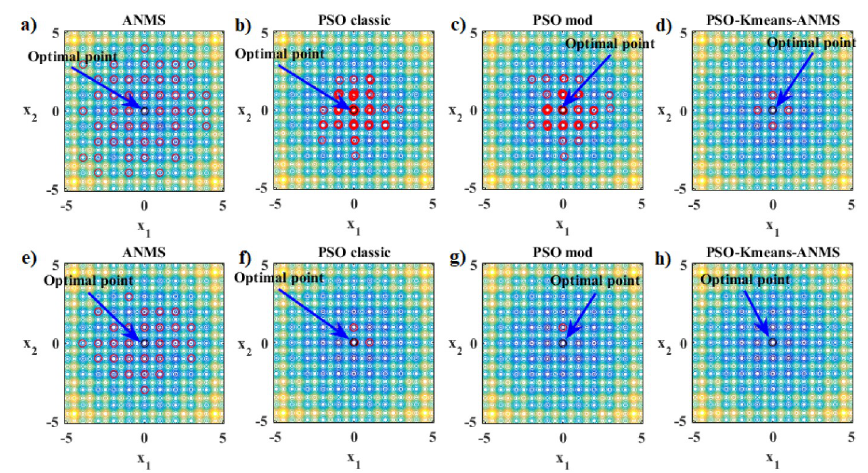
Fig 14. Simulations details for the Rastrigin function. The 100 results obtained by the algorithms ANMS, PSO classic, PSO mod and PSO-Kmeans-ANMS for the swarms with 08 (upper) and 36 (lower) particles, respectively.